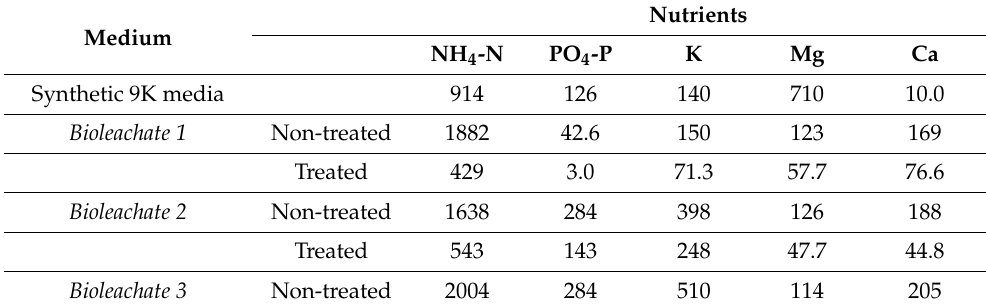
Table 3. Concentration (mg/L) of the soluble nutrients in the initial culture media and